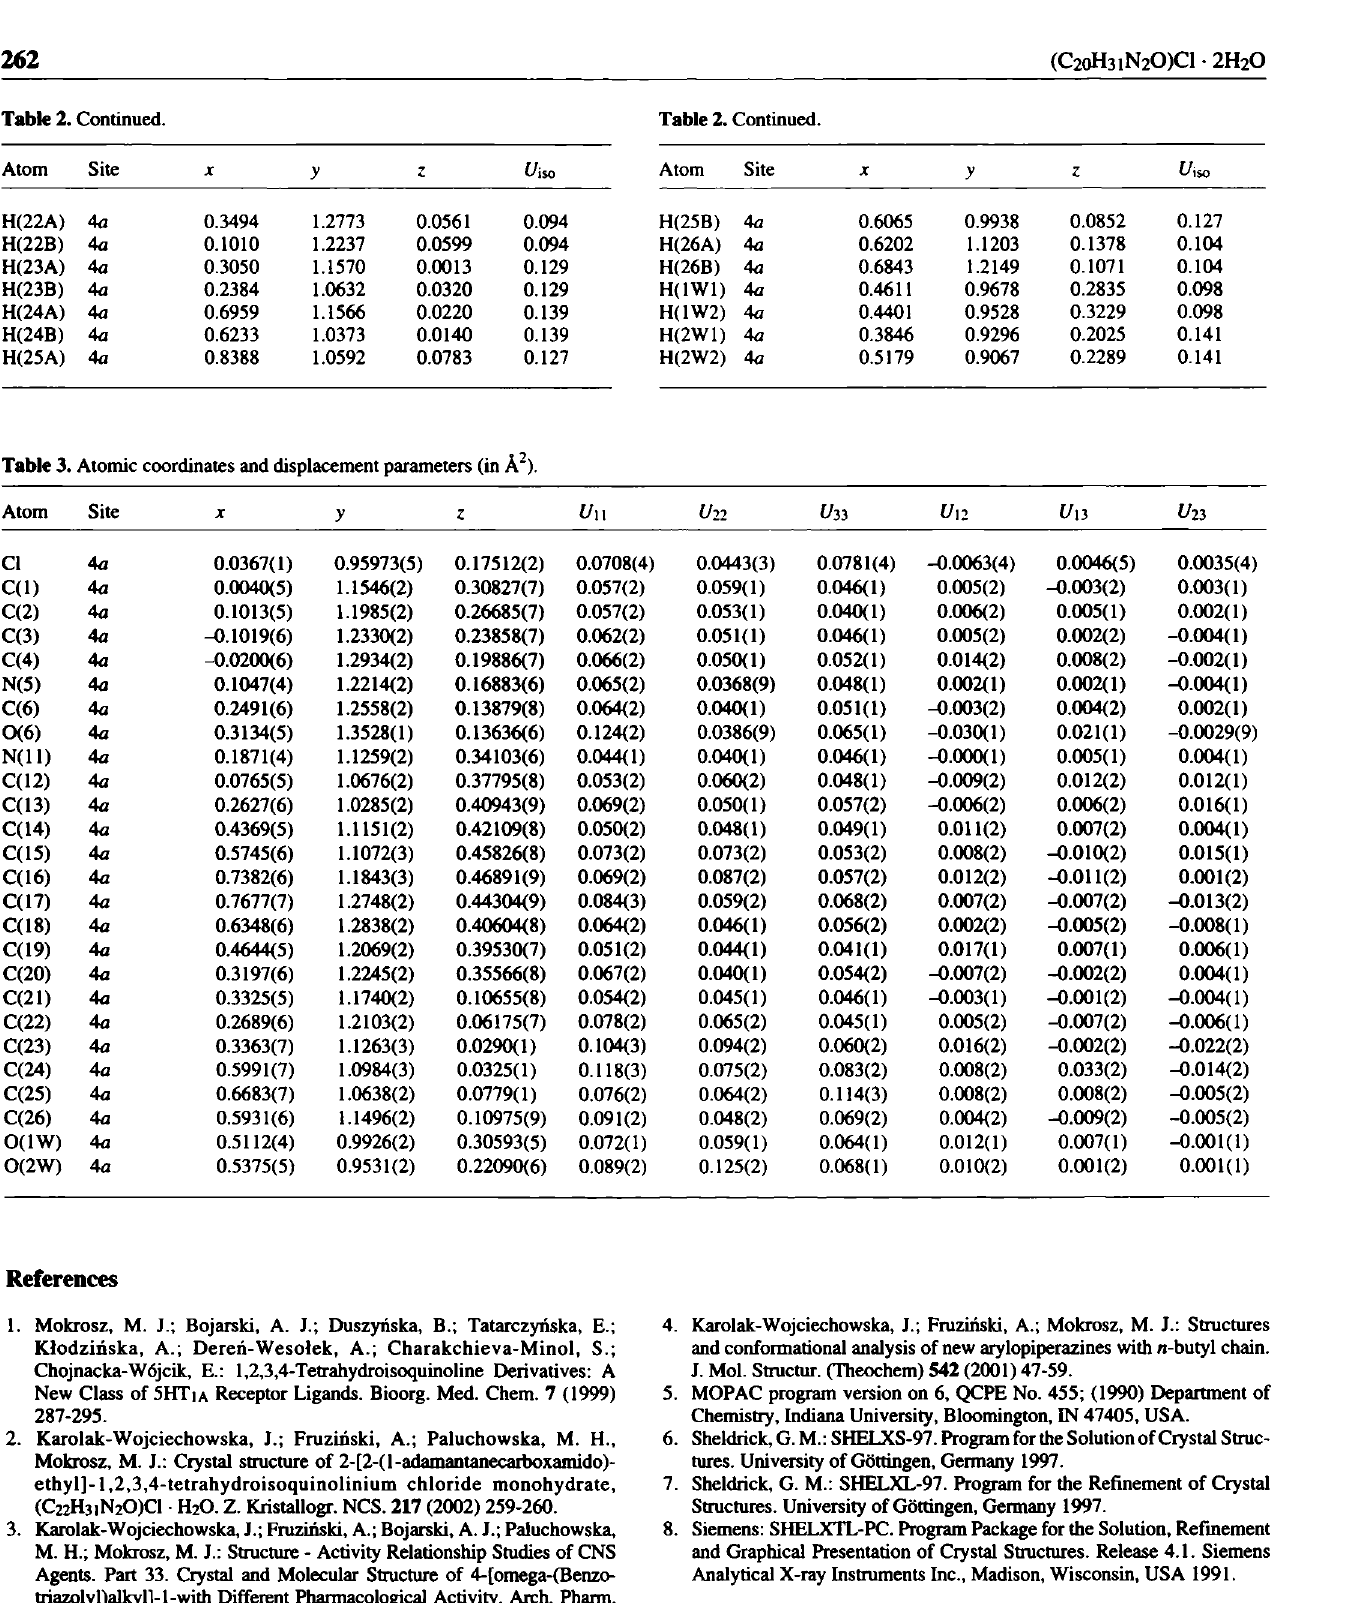
Table 3. Atomic coordinates and displacement parameters (in À 2